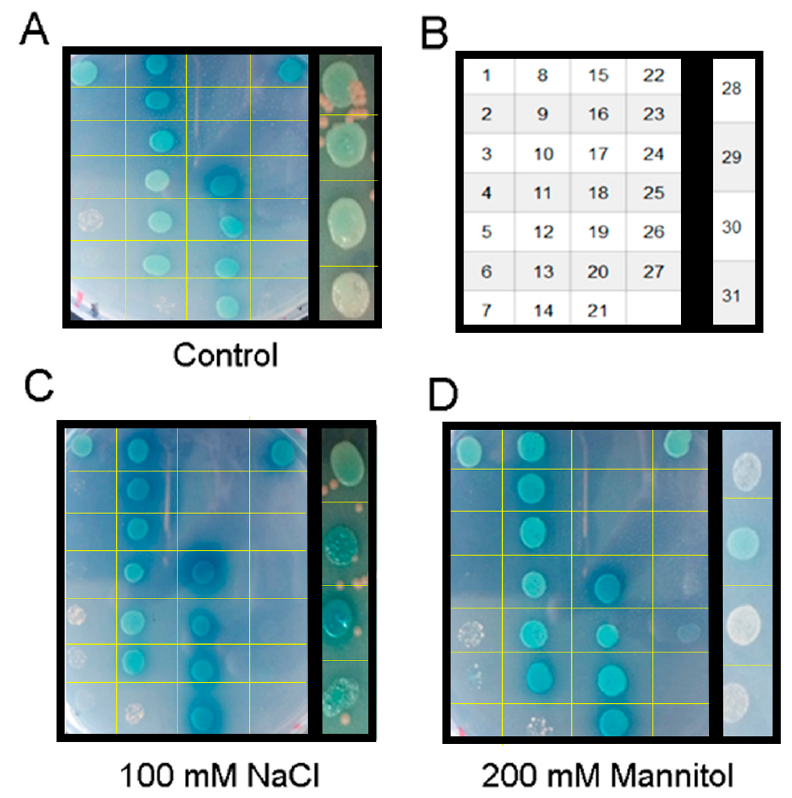
Figure 3. The effects of salt and osmotic stress on the interaction of Gm PIP1s with Gm PIP2s. ( A ) All the yeast clones mentioned in Figure 2 were plated on selective plates (SD-Leu-Trp-His-Ade) with AbA (100 ng × ml − 1 ) and X-a-gal. ( B ) The position of the yeast clones on the plates. ( C ) The clones were spotted on the selective plates SD-Leu-Trp-His-Ade with AbA (100 ng × ml − 1 ), X-a-gal and 100 mM NaCl. ( D ) The clones were spotted on the selective plates SD-Leu-Trp-His-Ade with AbA (100 ng × ml − 1 ), X-a-gal, and 200 mM